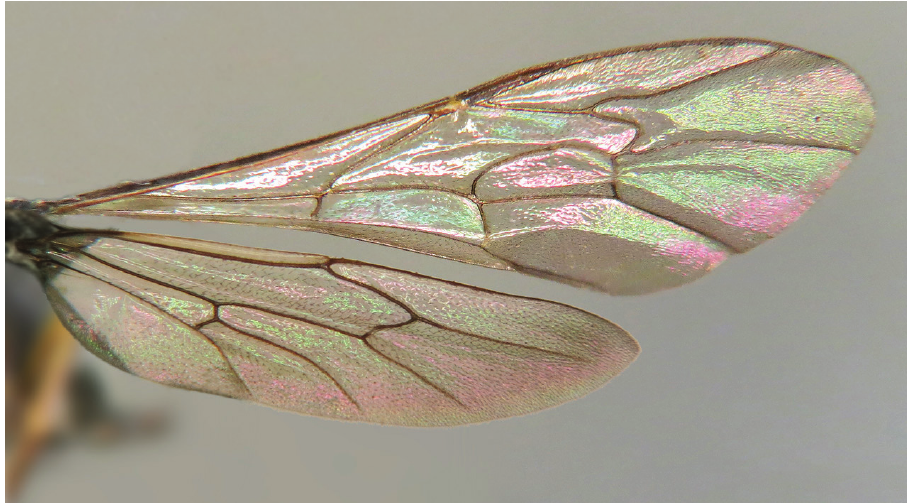
Figure 6. Heinrichiella obscura comb. n., wings (Netherlands) [combined from two images].